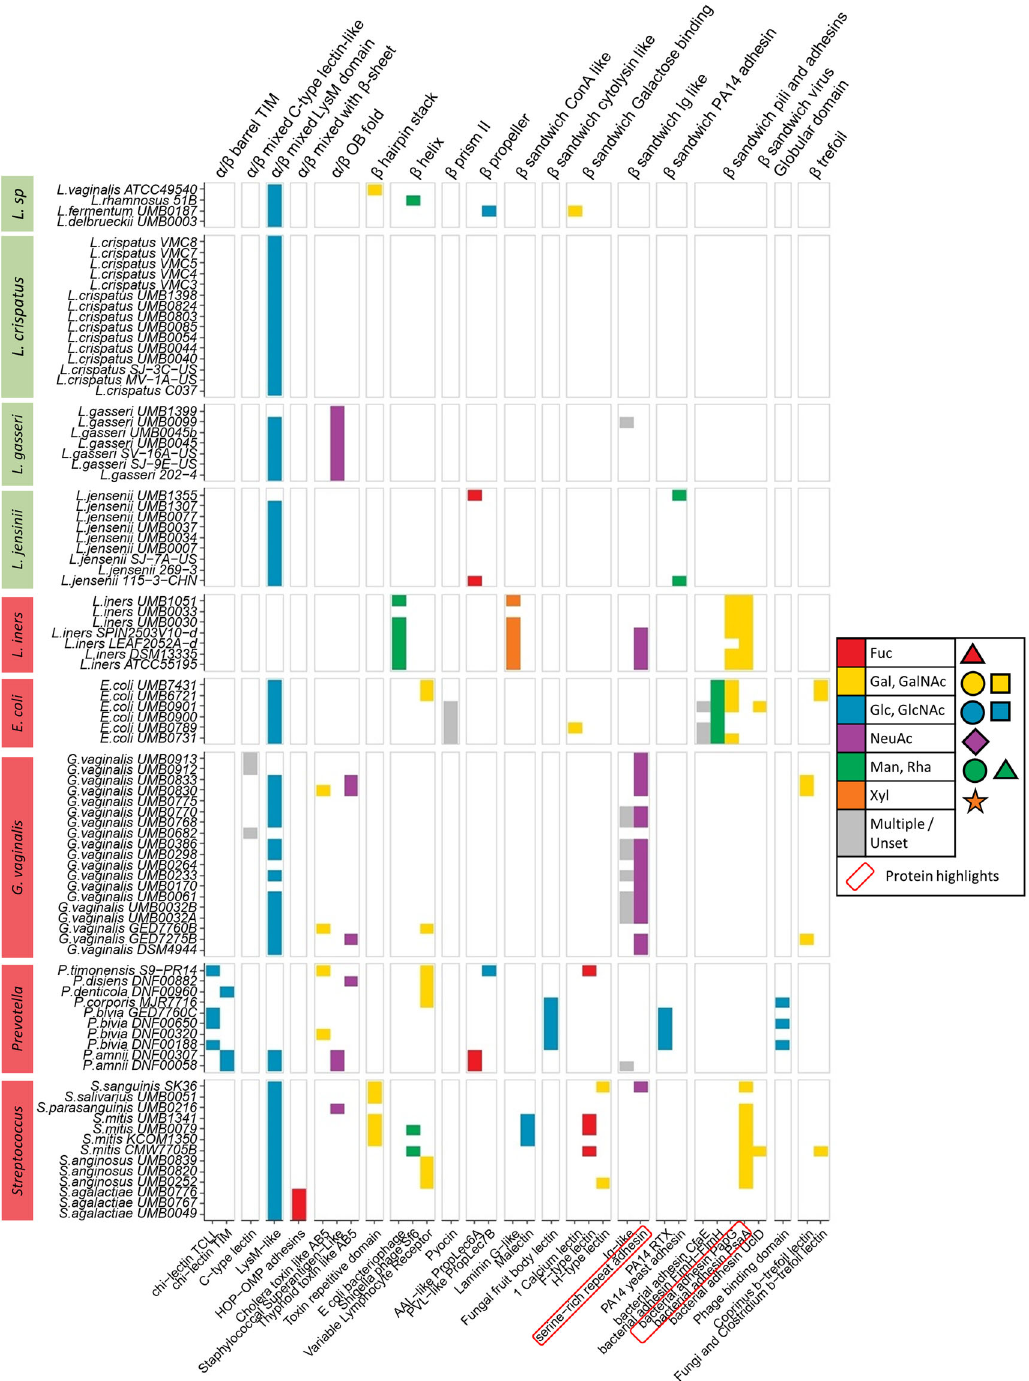
Fig. 3 Distribution of predicted lectomes classi fi ed by fold and class in different vaginal commensal, and con fi rmed and potentially pathogenic bacterial species. In the margins, commensal species are indicated by green, and con fi rmed and potentially pathogenic species by red. Colours within each class of lectin re fl ect their predicted glycan-binding speci fi city, indicated as the monosaccharide with most contacts at the binding site of crystal structures available, and are represented using the Symbol Nomenclature of Glycans (SNFG) (https:// www.ncbi.nlm.nih.gov/glycans/snfg.html). The lectin classes circled in red are further discussed in the ‘ Results ’ section to highlight their particular presence in L. iners . Accession numbers are listed in Supplementary Table fi sh F-lectins 52 . In our study, this fucose-binding module is identi fi ed in S. mitis and in some pathobionts, i.e., Provotella and L. iners . PsaA 53,54 , are part of the lectome of L. iners and their speci fi city for